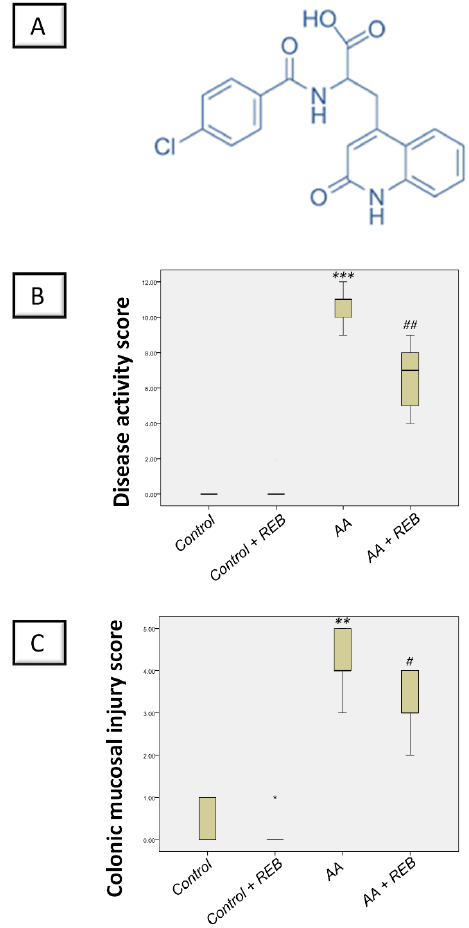
Figure 1. Rebamipide attenuates the colitis severity by lowering scores of the disease activity index and colonic macroscopical mucosal injury in rats. ( A ) The chemical structure of rebamipide. ( B ) The scores of the disease activity index (DAI) summarized by the clinical manifestations of colitis including the degree of weight loss, diarrhea, and rectal bleeding (presence of occult blood). ( C ) The colonic mucosal injury scores (CMIS) characterized by colonic hyperemia, mucosal erosion, and bleeding at the macroscopical level. The scores were expressed as the median with the interquartile range ( n = 6). The Kruskal–Wallis test was conducted to analyze the significant difference among tested groups followed by the Dunn’s test. ** p < 0.01, or *** p < 0.001, significant from the control group. # p < 0.05, or ## p < 0.01, significant from the colonic injury group. REB, rebamipide; AA, acetic acid.